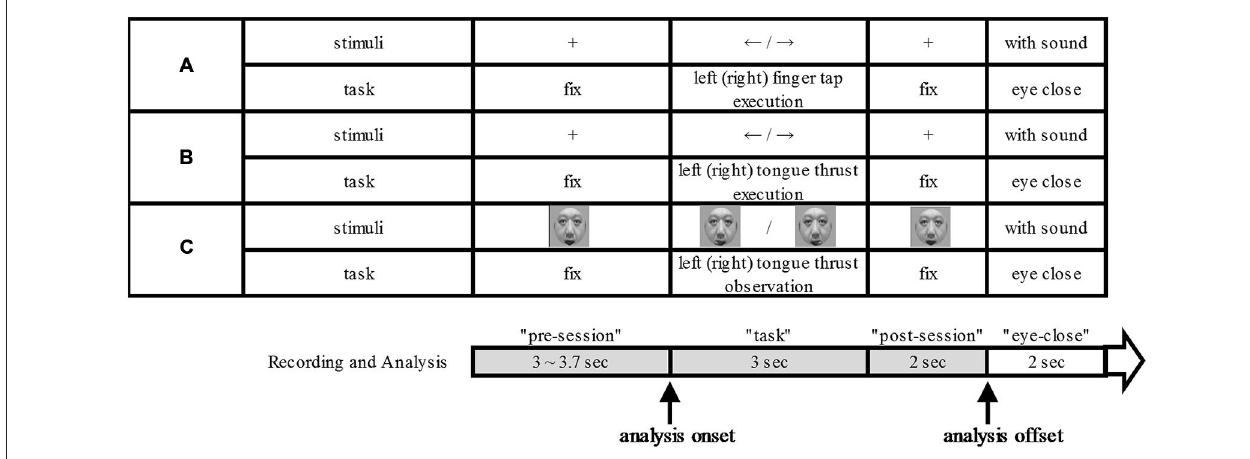
FIGURE 1 | Experimental scheme . The three tasks: finger tap execution (A) , tongue thrust execution (B) , and tongue thrust observation (C) . For each task (A–C) , the upper column shows the visual stimulus presented on the monitor and the lower column the task performed. Each trial was divided into four temporal epochs: “pre-session”, “task” (beginning with stimulus presentation), “post-session”, and “eyes closed”. The analysis onset means in relation to visual cue.